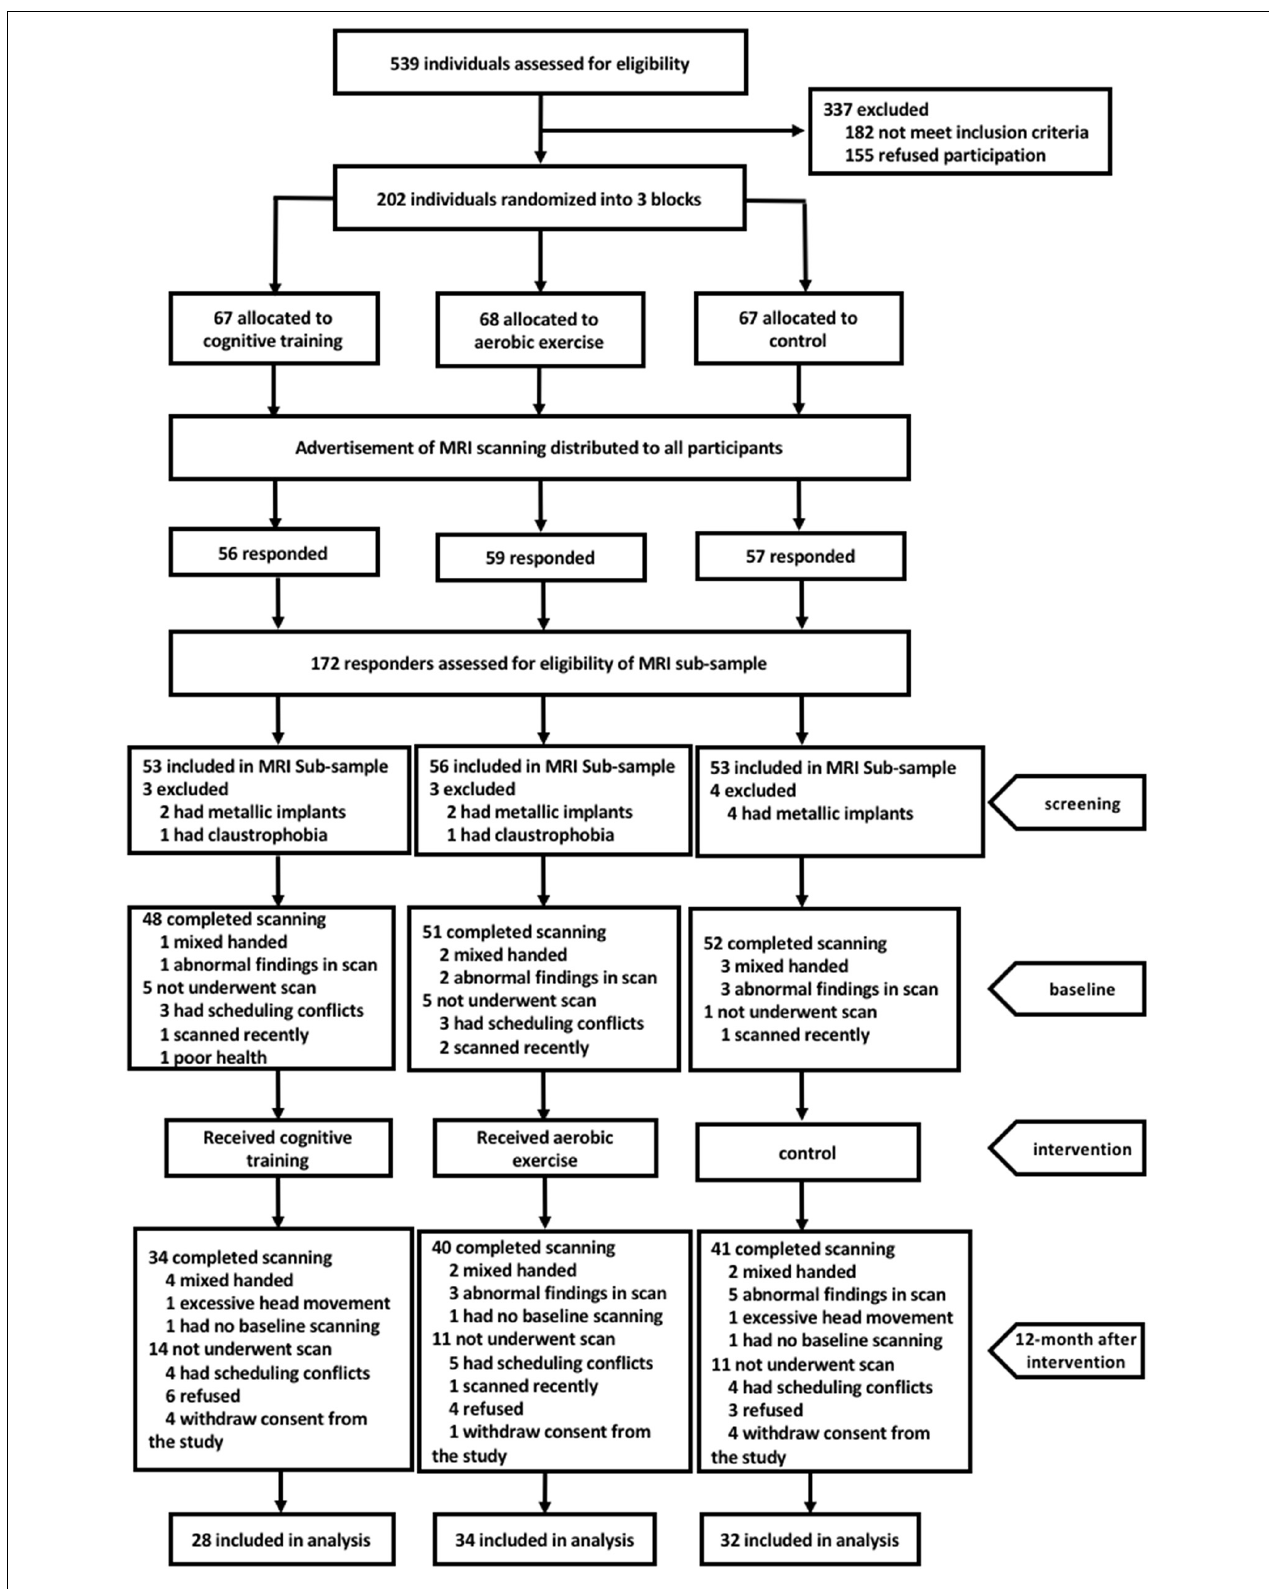
FIGURE 1 | Flow chart showing the recruitment process of study participants.